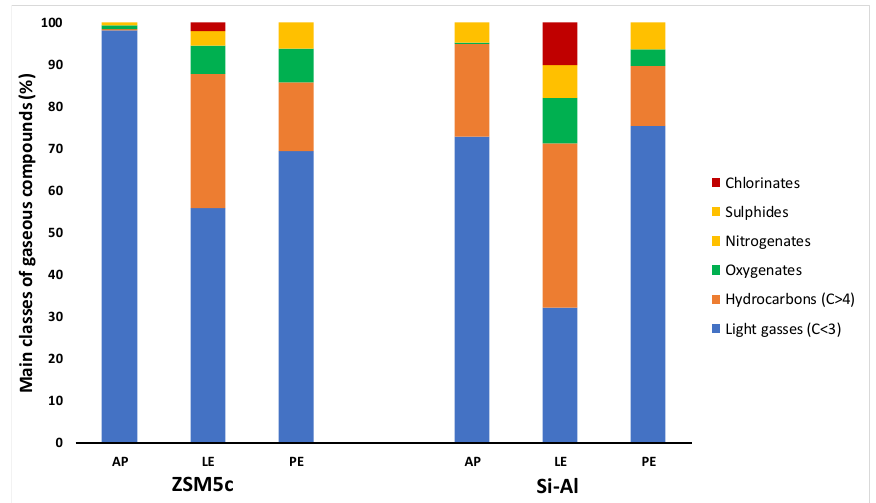
Figure 4. Percentage distribution (%) of the main classes of gaseous compounds from catalytic pyrolysis carried out using ZSM5 or SA as catalysts. Analytical determinations were made by GC–MS on gases from untreated Arthrospira platensis biomass (AP), biomass after lipid extraction (LE), biomass after protein extraction (PE). Table 2. Percentage composition (%) of gases from catalytic pyrolysis using ZSM5 or silica–alumina as catalyst in terms of individual compounds. Analytical determinations were made by GC–MS on gases from untreated Arthrospira platensis biomass (AP), biomass after lipid extraction (LE), biomass after protein extraction (PE).